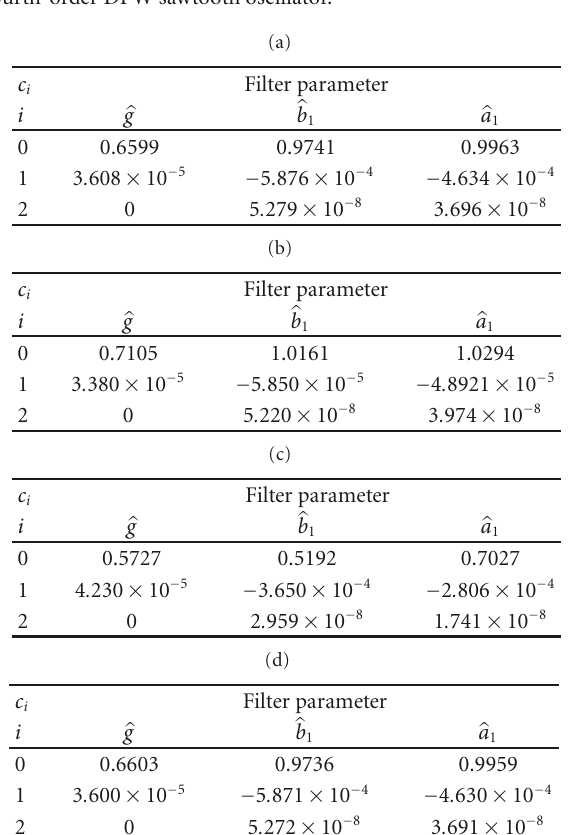
Table 4: Coe ffi cients of the polynomial fits for the first-order post- equalising filter parameters for (a) the third-order B-spline BLIT, (b) the fourth-order BLEP, (c) the second-order DPW, and (d) the fourth-order DPW sawtooth